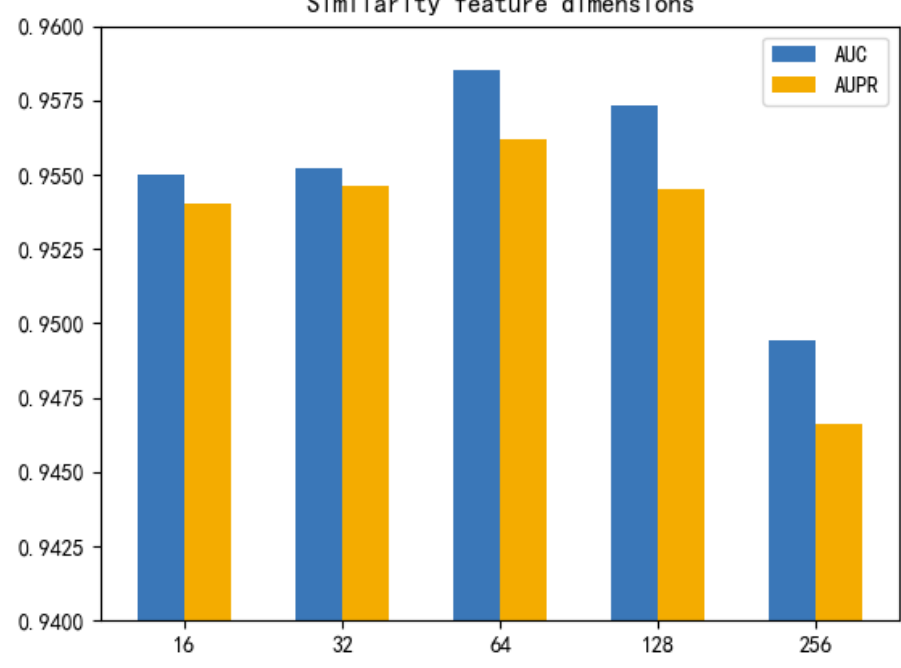
Figure 4. AUC and AUPR in different similarity feature dimensions under 5-fold